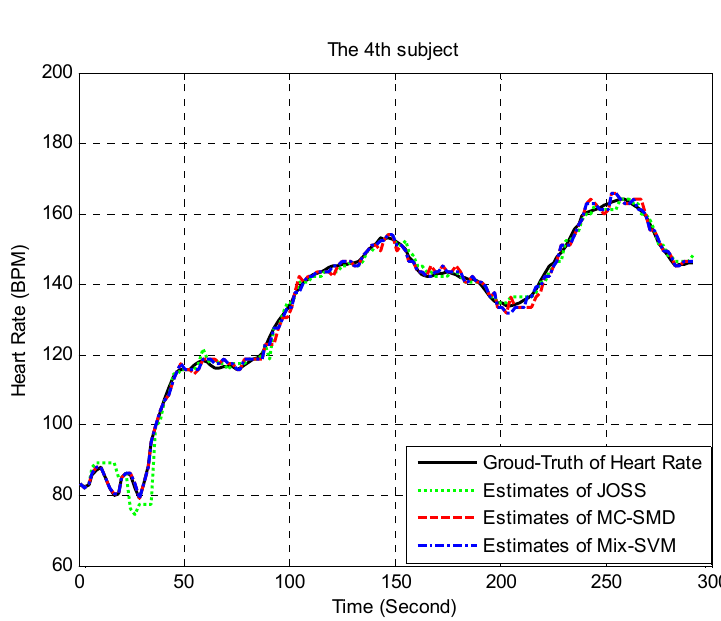
Figure 5. Estimation results on subject 4 for JOSS, MC-SMD, and Mix-SVM.